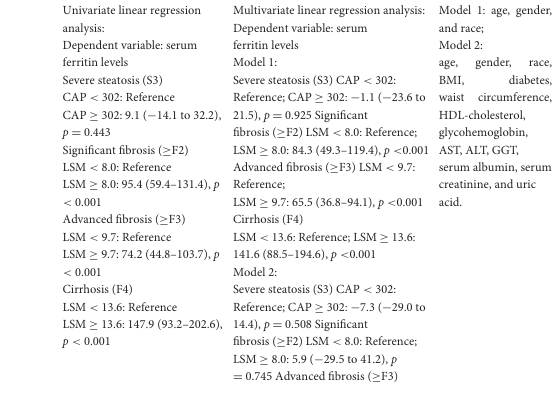
Yang,2022(53) Cross-sectional US AdultNAFLD 1,604(856 + 748) 52.73 ± 16.26 Vibration study patients